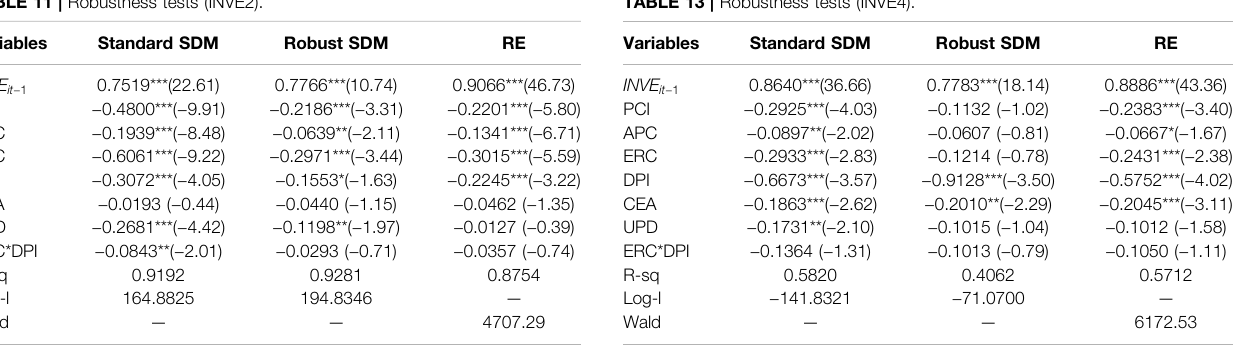
TABLE 13 | Robustness tests